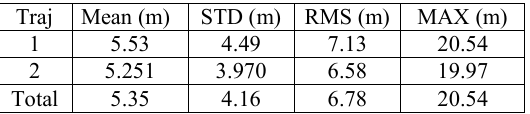
Figure 10 . The Time Series of the Difference between the WiFi Positioning Results and the Position Reference Truth. (a) and (b) are the Results of Experimental Routes 1 and 2 respectively Table 5 . The Statistical Value of Positioning Error